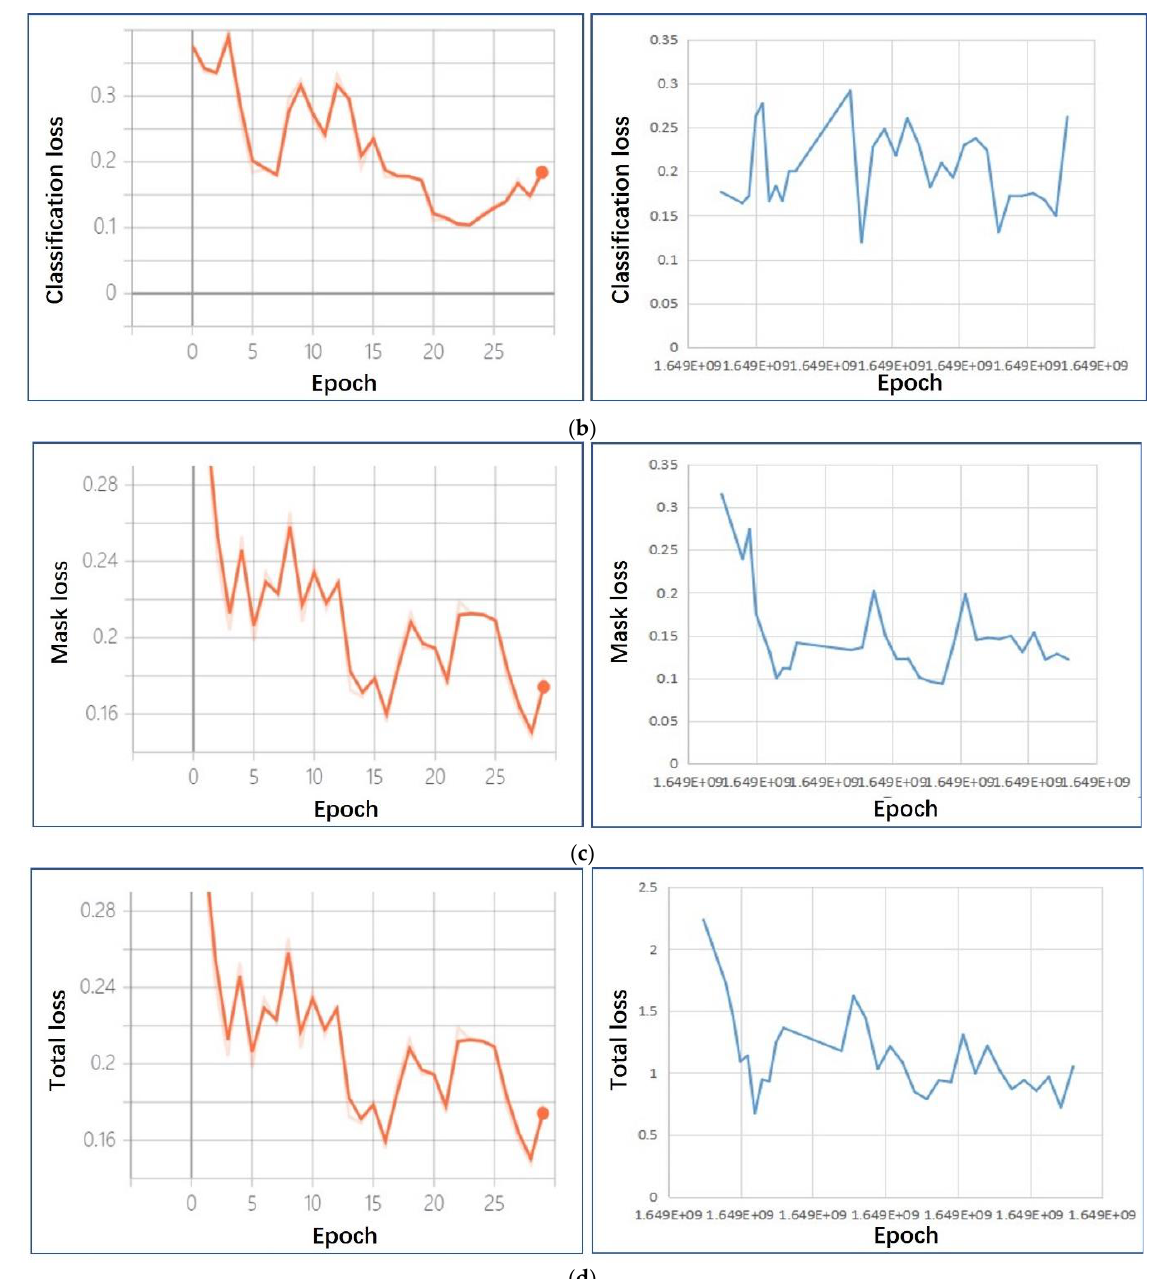
Figure 7. Analysis and comparison of loss function effects before and after optimization. ( a ) The comparison of bounding-box loss; ( b ) The classification loss comparison of the output target; ( c ) The mask loss comparison of the output target; ( d ) The comparison of total loss. After the comparison of the above functions, the optimized function is relatively smoother, indicating that the optimized effect is better than that before optimization and proving that the improvement is effective. Both the slight crack and the severe crack can be detected by the model. Because the width of the crack is smaller, the detection accuracy